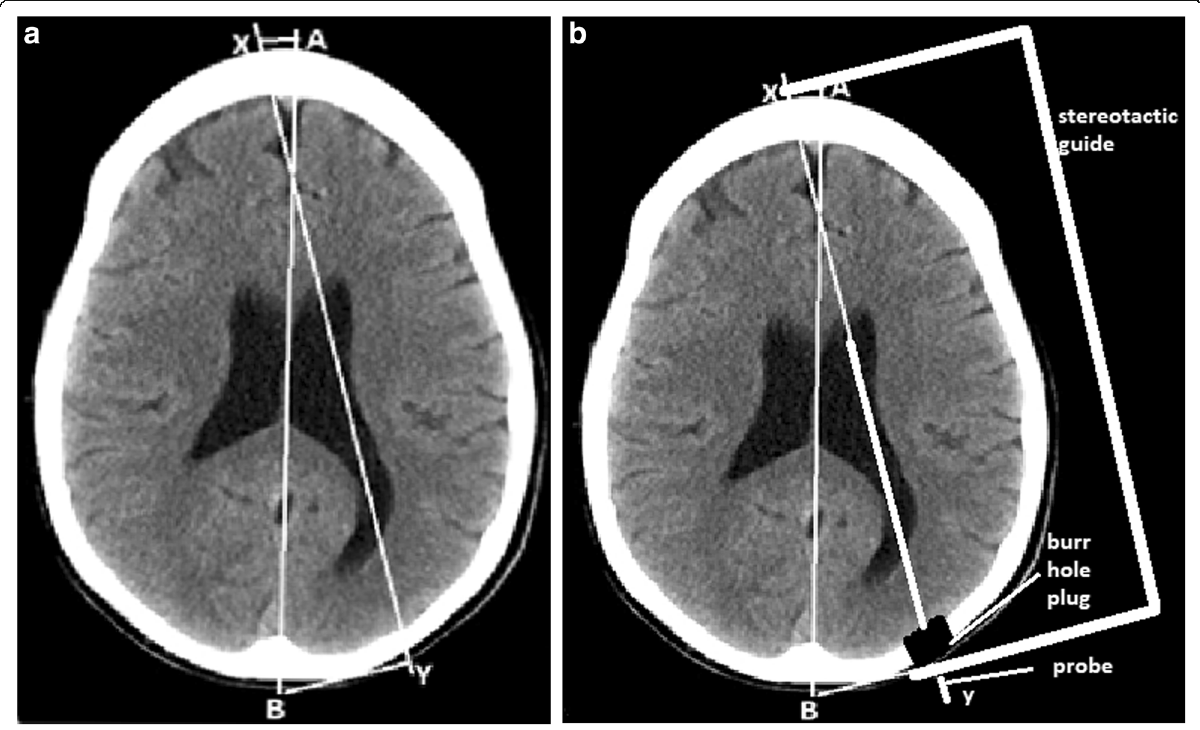
Fig. 2 a Trajectory XY. b Application of the system